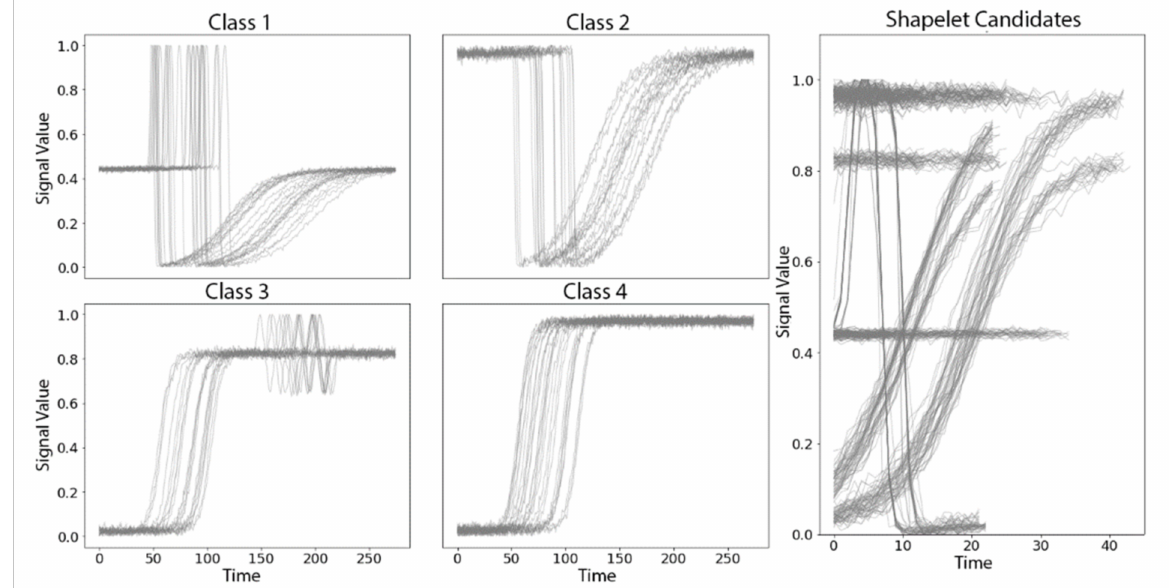
Figure 5. Time series from the four classes in the synthetic TRACE dataset ( left panels ) and the initial set of candidate shapelets identified by W-TSS ( right panel ). X-axis: time, Y-axis: risk of instrumentation